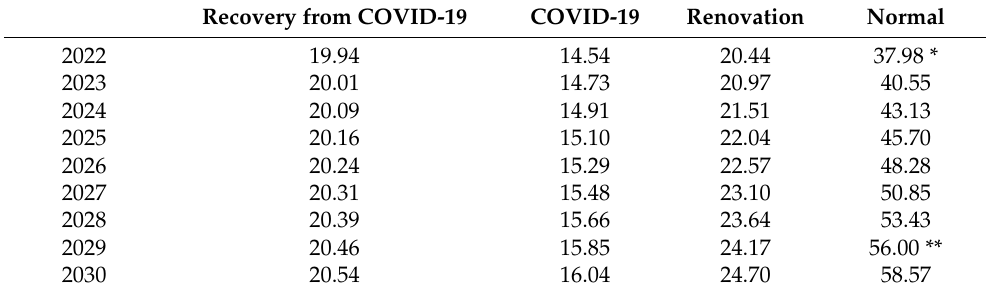
Table 15. Peak 3-h traffic forecasts